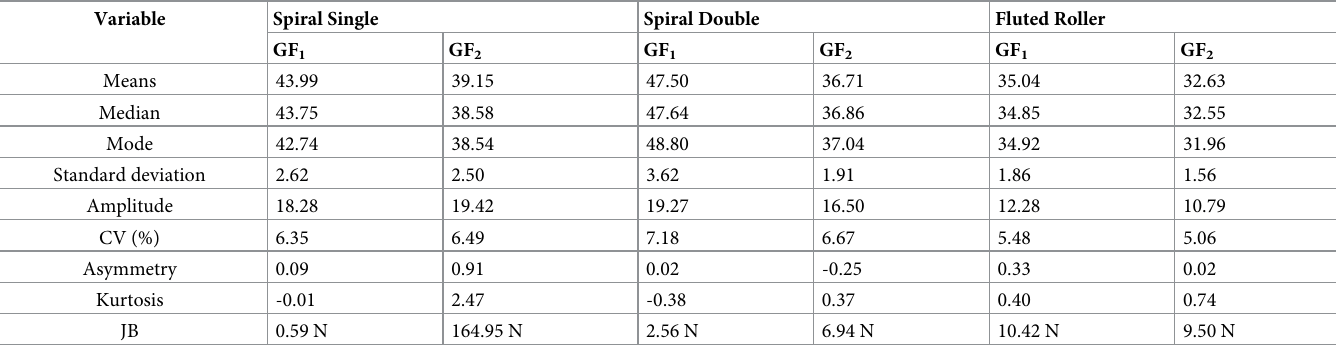
CV, coefficient of variation (%); JB, Jarque-Bera normality test (N, normal distribution; A: non-normal distribution at p � 0.05; AA, non-normal distribution at p � 0.01); GF, granular